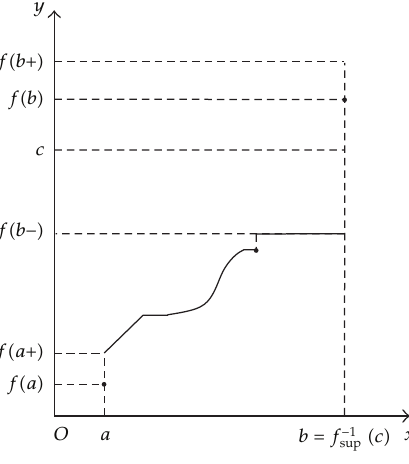
Figure 3: The equality